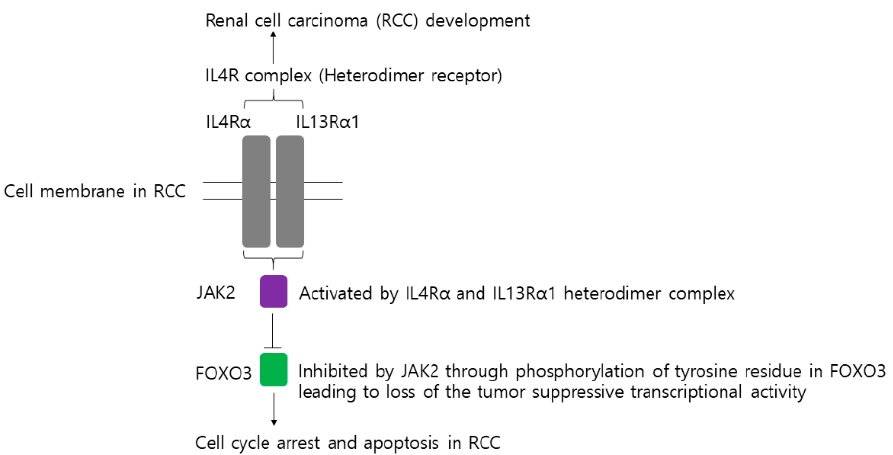
Figure 6. A diagram describes the role of IL4R complex (a heterodimeric complex of IL4R α and IL13R α 1) in promoting RCC tumorigenesis via phosphorylation of tyrosine residue in FOXO3 by activation of JAK2 leading to loss of the tumor-suppressive transcriptional activity.